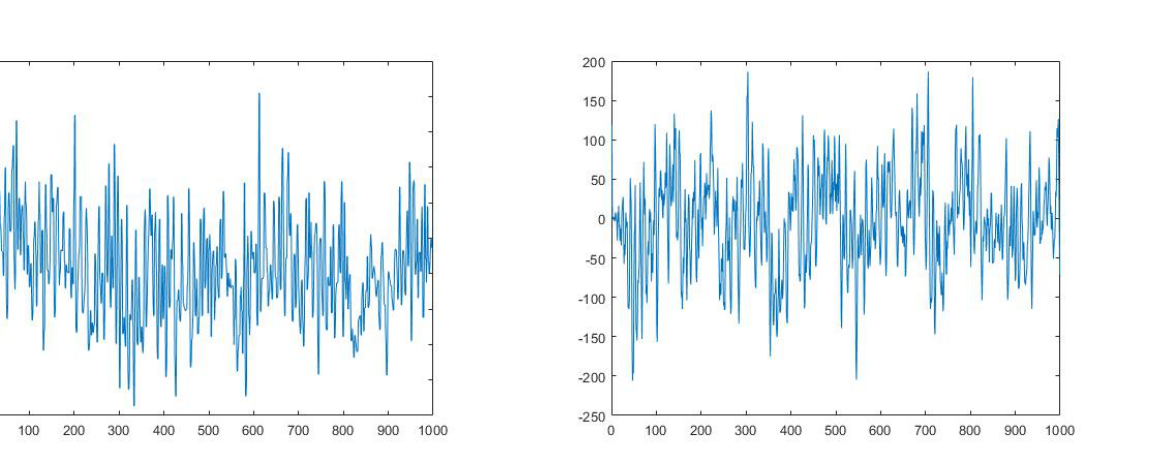
Figure 12. chb03-03 OWA Output